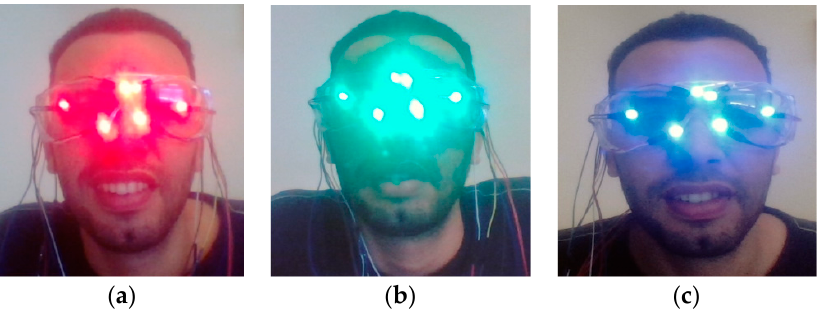
Figure 10. FacePET wearable powered on with different colored LEDs. ( a ) Red; ( b ) Green; ( c ) Blue.